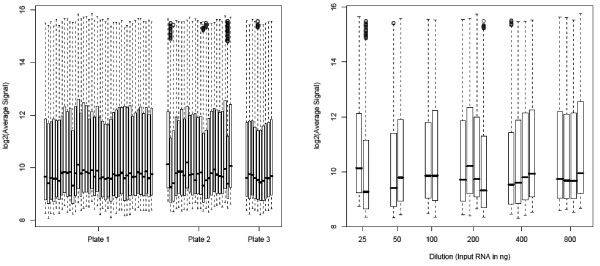
Signal distribution by plate and input RNA. Left panel: Pre-normalization box and whisker plots depicting distribution of probe intensities for technical replicates on SAMs 1, 2, and 3. The vertical axis is log base 2 intensity and the horizontal axis is SAM well ID. The bottom and top of the box represent the 25th and 75th percentiles of the probe expression values. The horizontal bar inside the box represents the median. The whiskers extend to either 1.5 times the interquartile range (75th percentile minus the 25th percentile) or the most extreme point, whichever is shorter. Points beyond the whiskers indicate outliers. No global shift in distribution is seen between plates. Right panel: Pre-normalization box and whisker plots depicting distribution of probe intensities at various amounts of starting material. The vertical axis corresponds to a log base 2 intensity, while the horizontal axis corresponds to the ng of starting material.